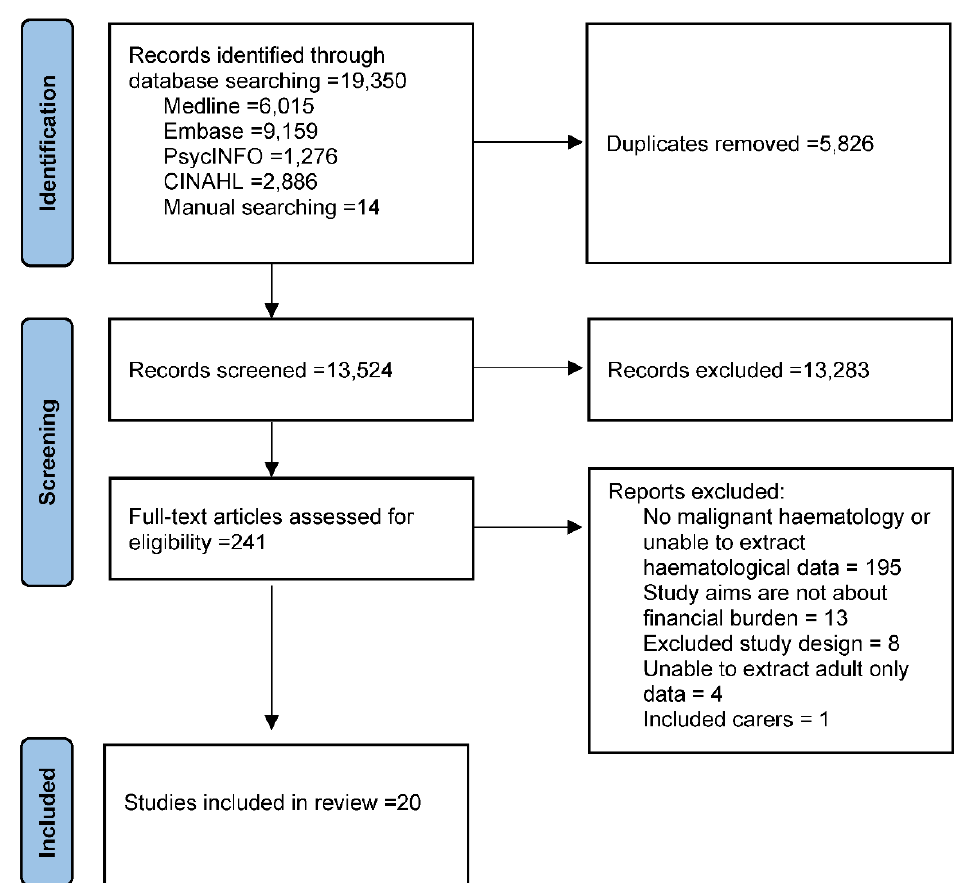
Figure 1. Preferred Reporting Items for Systematic Reviews and Meta-Analysis